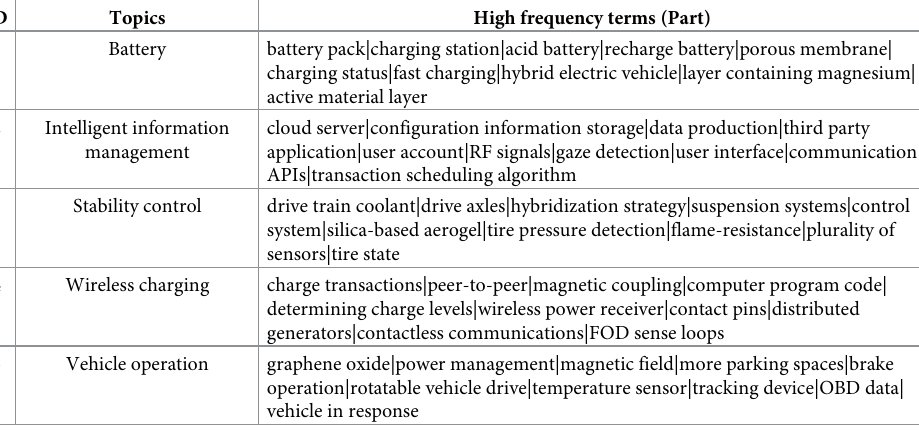
Table 7. Technological frontier topics in the EV